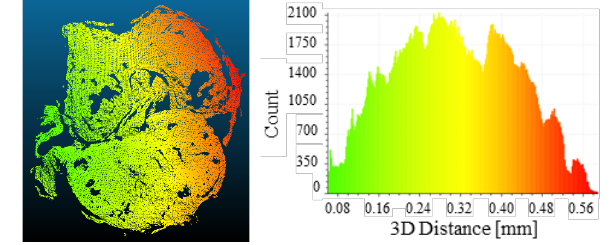
Figure 10. Euclidian distances between corresponding points of two point clouds. Exemplarily, the oriented cloud of the reference dataset at 120° is compared to the oriented cloud of VO_tri (No. 7 in Table 2). The right image shows the histogram of the 3D distances. In Figure 10, the Euclidian distances between oriented reference and oriented point cloud using VO are visualised. It can be seen that the exemplarily shown point cloud of VO is tilted so that deviations to the nominal point cloud increase diagonal from left to right. The mean 3D distance of 120°, 240° and 360° oriented point clouds for each dataset of Table 2 is given as well as the